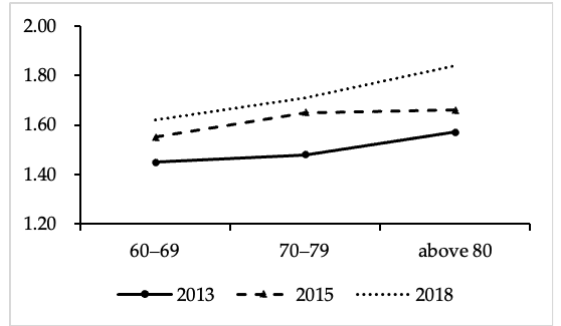
Figure 3. Age trends in loneliness by survey time point.